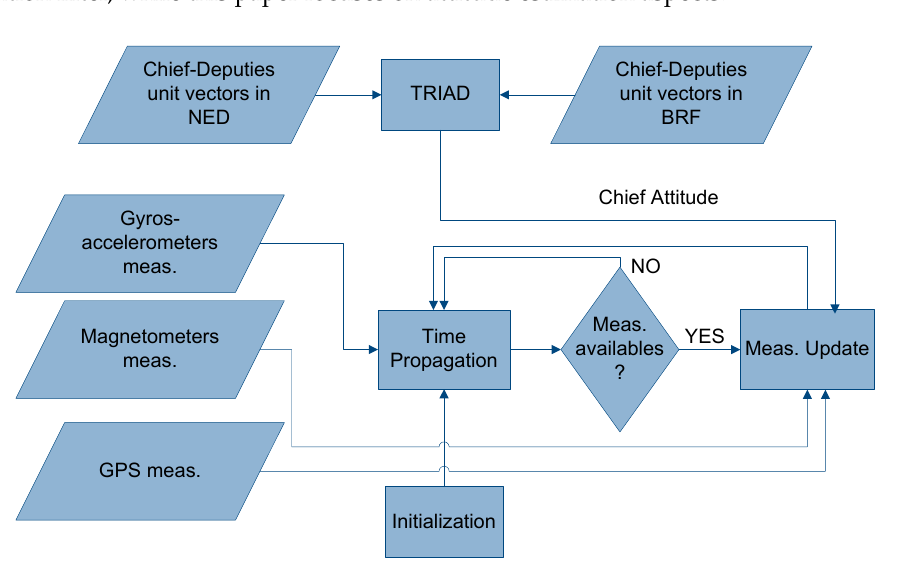
Figure 2. Multi-sensor fusion.